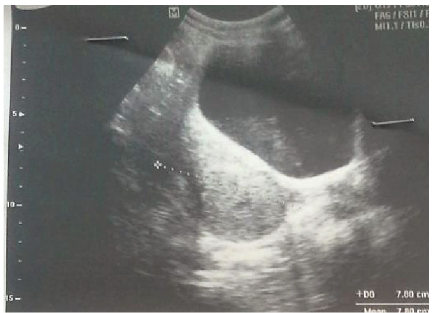
Figure 1: Ultrasonography of uterine inversion.